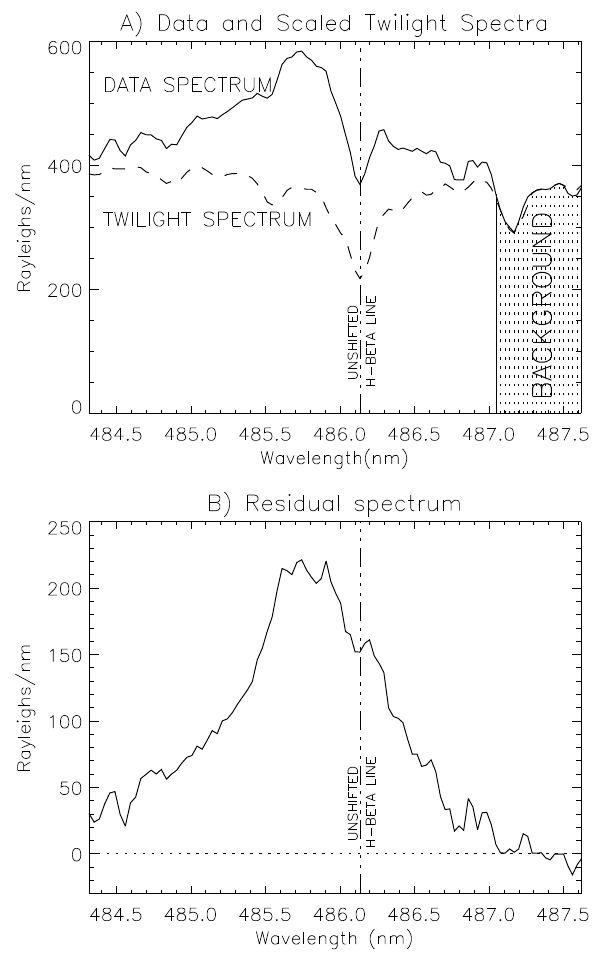
Fig. 6. (A) A measured spectrum (solid line), integrated for 60s beginning at 09:25:22 UT on 27 November, 2000. The φ –scaled twilight spectrum is drawn as a dashed line. (B) The residual spec- trum after the scaled twilight spectrum has been subtracted from the data spectrum.